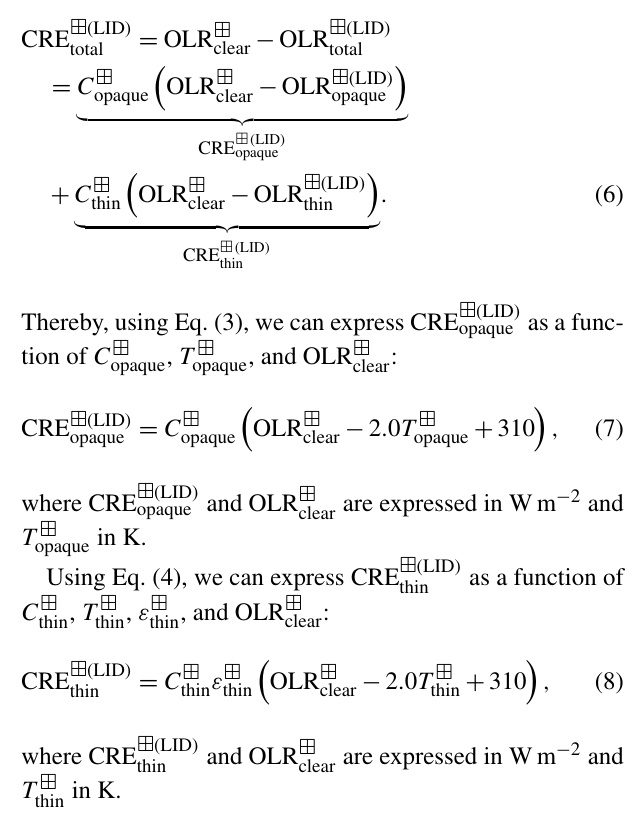
Figure 6. Comparison between observed and lidar-derived OLR at CERES footprint scale: (a) over opaque-cloud single columns and (b) over thin-cloud single columns. Results obtained from CERES ( y axis) and CALIOP ( x axis) collocated measurements. OLR (cid:11) ( LID ) and OLR are computed using Eqs. (4) and (5). Only nighttime conditions over ice-free oceans for January 2008 are considered. R is thin the correlation